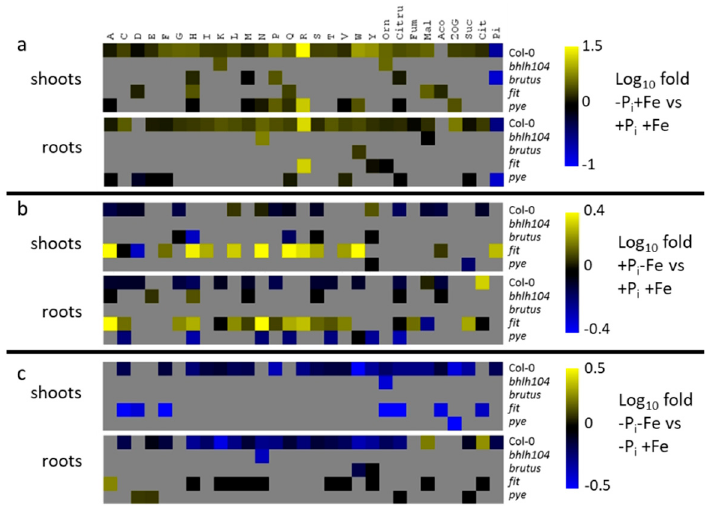
Figure 8. Metabolite changes in shoots (upper panels) and roots (lower panels) of Col-0 plants and mutants with impaired expression of Fe deficiency response regulators. ( a ) response to P i deficiency in the presence of Fe ( − Pi+Fe vs. +P i +Fe); ( b ) Fe deficiency response in the presence of P i (+P i − Fe vs. +P i +Fe); ( c ) response to combined Pi and Fe deficiency compared to P i deficiency ( − Pi − Fe vs. − Pi+Fe). After an initial growth period of five days on nutrient sufficient conditions (+P i +Fe), seedlings were transferred to the indicated conditions and allowed to grow for an additional six days before harvest. +P i : 500 µ M, − Pi: 5 µ M, +Fe: 50 µ M, − Fe: no Fe added. The log 10 fold changes are color coded. For Col-0, only changes at p ≤ 0.05 (Student’s t -test two tailed, equal variances) are color coded. For the mutants, changes are color coded, if the metabolic response was different compared to the Col-0 response at p ≤ 0.05 (two way ANOVA, n ≥ 8). Grey boxes indicate no change in metabolite concentrations in Col-0 by the respective treatment, or no difference in the metabolic response to the respective treatments between mutants and Col-0. Orn: ornithine; Citru: citrulline; Fum: fumarate; Mal: malate; Aco: aconitate; 2OG: 2-oxoglutarate; Suc: succinate; Cit: citrate. Heat maps have been generated according to the data shown in Datasets S7 and